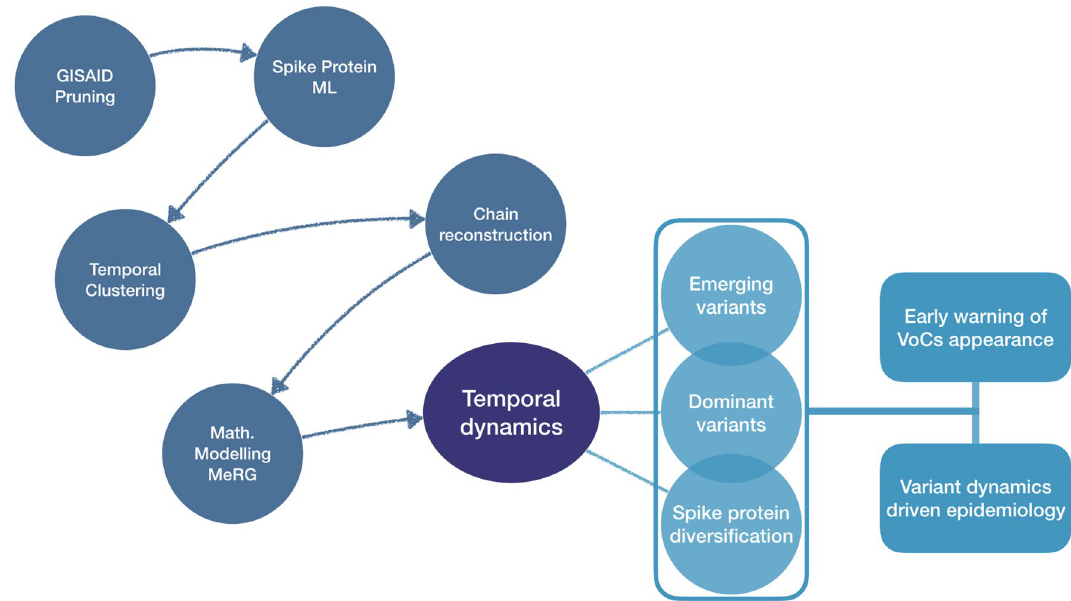
Figure 1. Methodology and main outcomes. Schematic representation of the work-flow we follow in this work. The figure is read from left to right, with the blue circles summarising the main steps of our investigation, with leads to a reconstruction of the temporal dynamics of the diffusion of the variants (dark blue oval). The arrows show their logical sequence. Intermediate results are assembled in the vertical box. In the light blue boxes on the right, we summarise the two main applications of the results: the early warning tool for the appearance of relevant variants and the reconstruction of the variant epidemiological